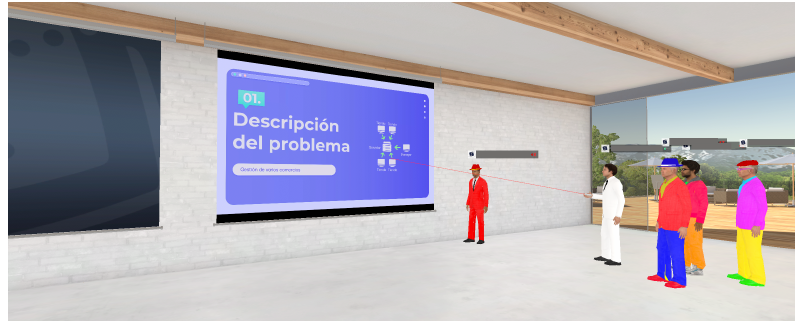
Figure 4. Students using a projector and laser pointer for a presentation in